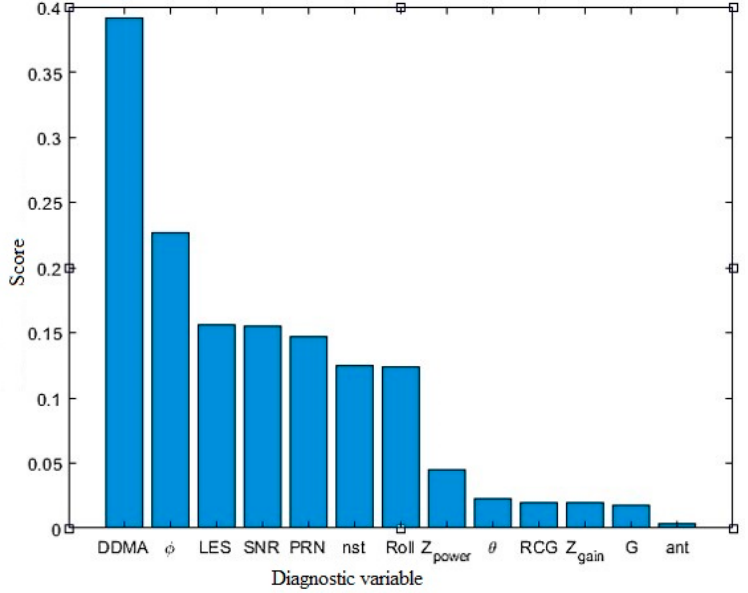
Figure 11. Dominant diagnostic variables in identifying outliers. Variable definitions are provided in